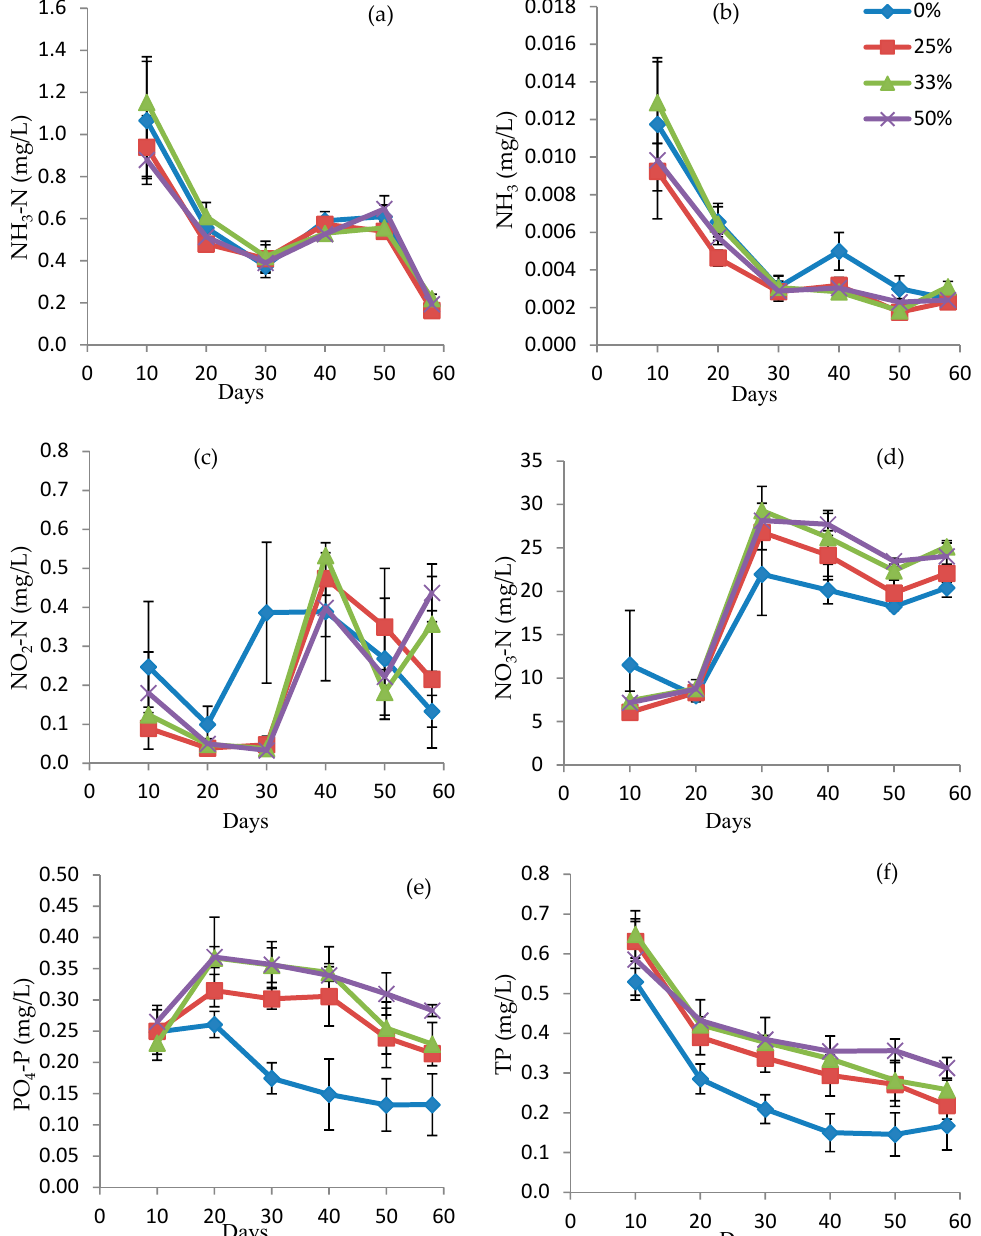
Figure 2. Concentrations of ( a ) ammonia nitrogen; ( b ) un-ionised ammonia; ( c ) nitrite nitrogen; ( d ) nitrate nitrogen; ( e ) orthophosphate; and ( f ) total phosphorus (TP) in tanks of Cyprinus carpio reared in an integrated recirculating aquaponic system for a 58 day trial (data are the means of three replicates (n = 3), and error bars indicate the standard